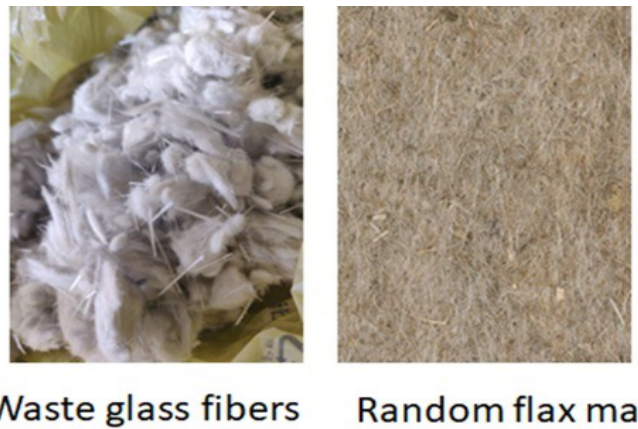
Figure 2. Reinforcements used in this study ( left ) waste glass fibers and random flax mat ( right